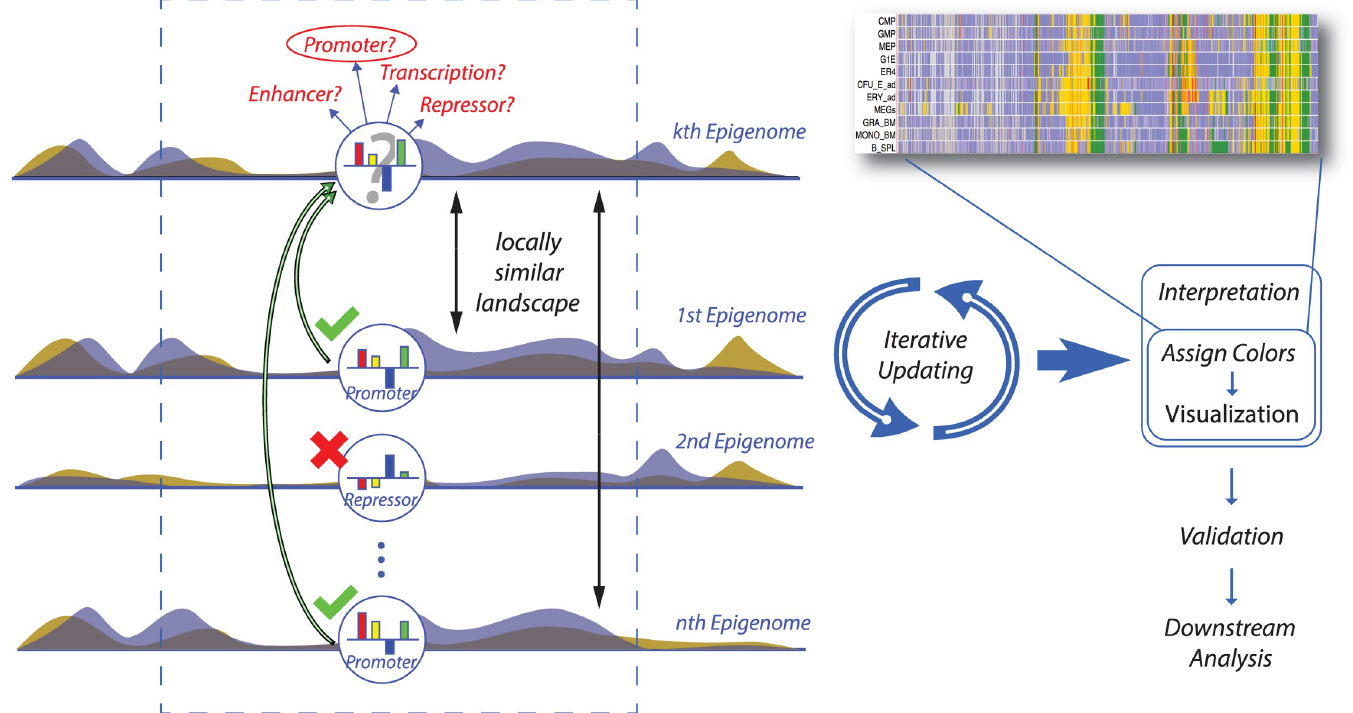
Fig 1. Illustration of the IDEAS method. When making an inference at a locus in a target cell type, IDEAS first identifies a set of cell types that share locally similar chromatin landscapes with the target cell type. Then IDEAS makes predictions based on the chromatin marks in the target cell type and the predictions made in the locally related cell types at the same locus. The IDEAS algorithm is a full Bayesian nonparametric probabilistic model. All model parameters, except for hyper parameters, are learned from the data, including number and parameters of chromatin states, size of local intervals, number of cell type clusters, and locus-specific profiles.